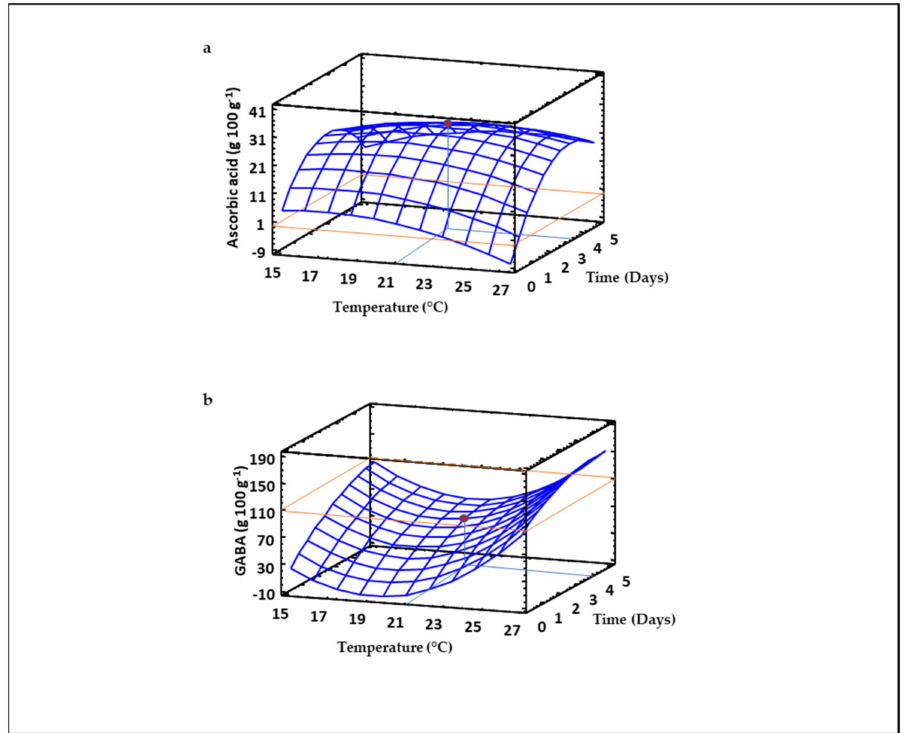
Figure 5. Three-dimensional response surface plots for the content of ascorbic acid ( a ) and GABA ( b ) as a function of the interaction between germination temperature and time. The red line corre- sponds with the control (ungerminated seed) and the red point with the value for optimum conditions (21 ◦ C and 3.5